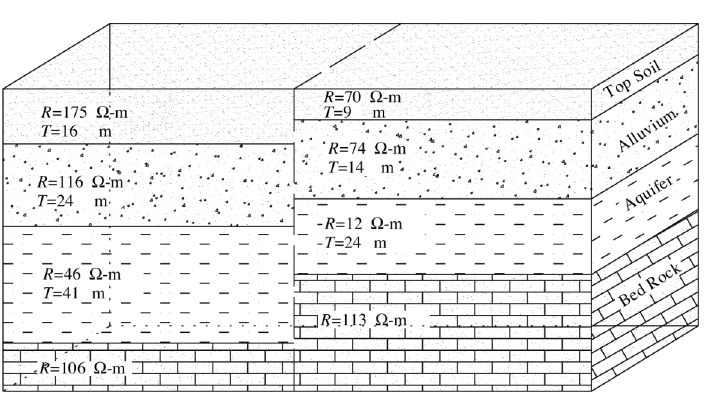
Fig. 5. Subsurface layers in the eastern and western parts of the aquifer. T – thickness; R –